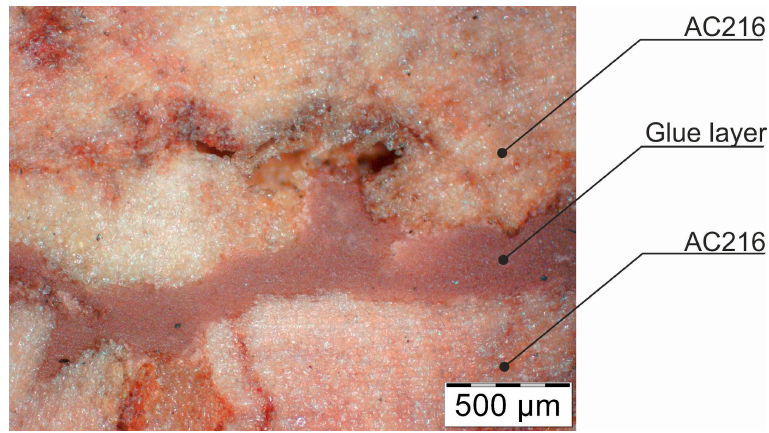
Figure 7. The photograph of the glue layer between AC216 cork outer layers.